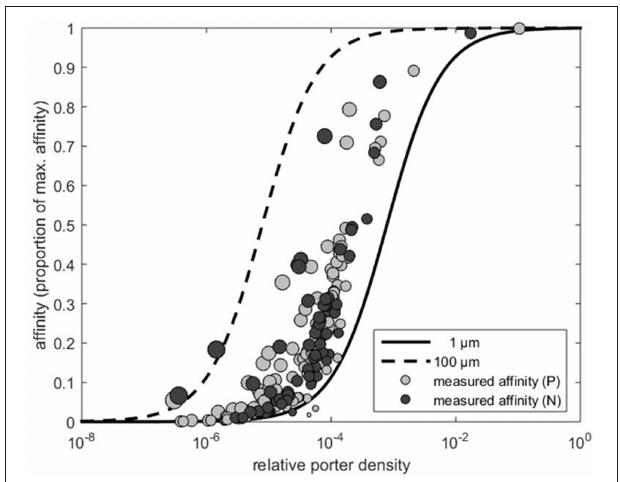
FIGURE 1 | Affinity expressed as the proportion of the theoretical maximum (i.e., α/α max ) as a function of estimated transporter density (obtained by Equation 3). The dashed and solid lines represent the affinity predicted by Equation (2) for cells with a radius of 1 and 100 µ m, respectively. Light gray and dark gray circles indicate the affinity and the corresponding transporter estimates extracted from Edwards et al. (2015) for phosphate (P) and nitrate (N), respectively. Area of the circles indicate cell